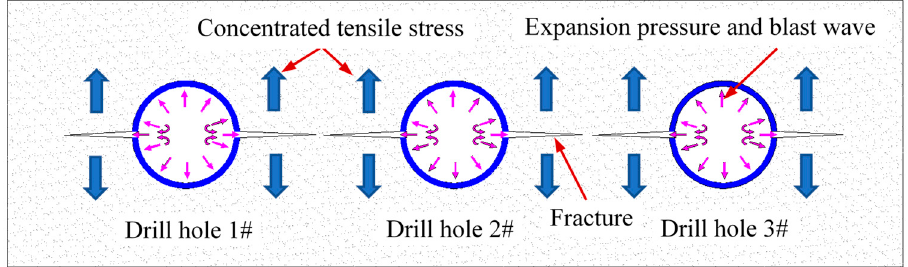
Figure 7. Stress model of directional presplit cumulative blasting.